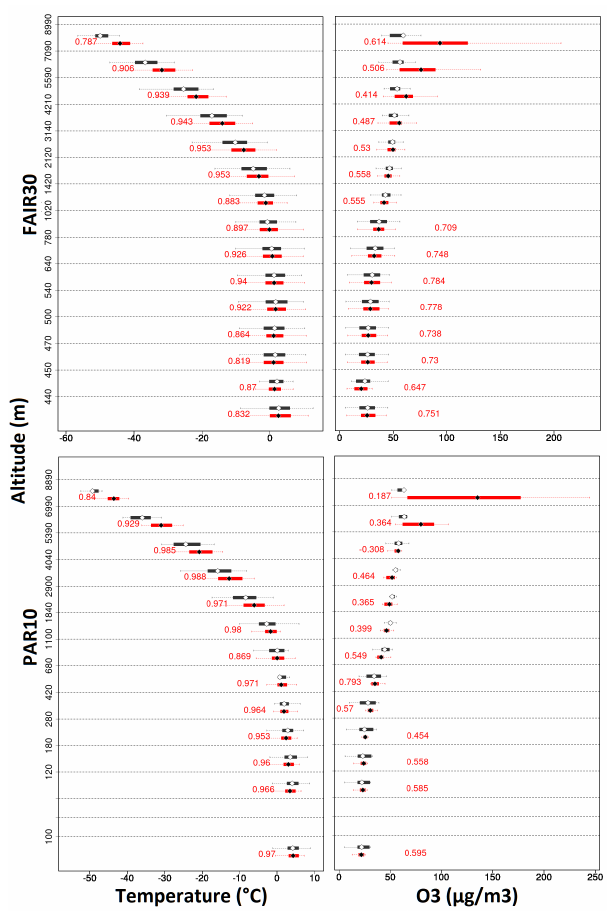
Figure 4. Vertical profiles for FAIR30 (first row) and PAR10 (second row) for temperature (in ◦ C, first column) and O 3 (in ppb, second column). Red bars represent the simulations while black bars represent measurements. The point shown on each bar shows the average for the simulation, while the correlation for each level is in red beside the